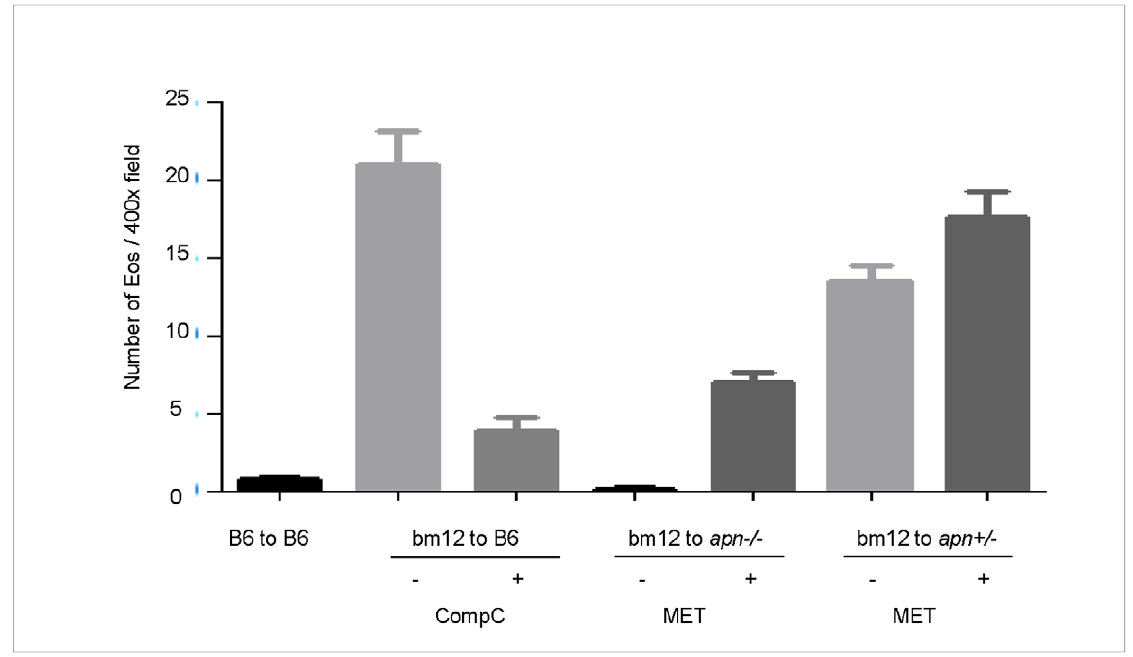
Figure 4. Effect of adiponectin signaling pathway inhibitors and agonist on MHC class II mismatched skin transplantation. For skin transplantation bm12 mice were used as donors and B6, Apn–/– or APN + /- mice as recipients (n=6 each). The animals were treated with Compound C (CompC, 5 mg/kg/day), Metformin (MET, 250 mg/kg/day) and the grafts were obtained at day 7 after transplantation. The number of eosinophil was counted the average is shown.